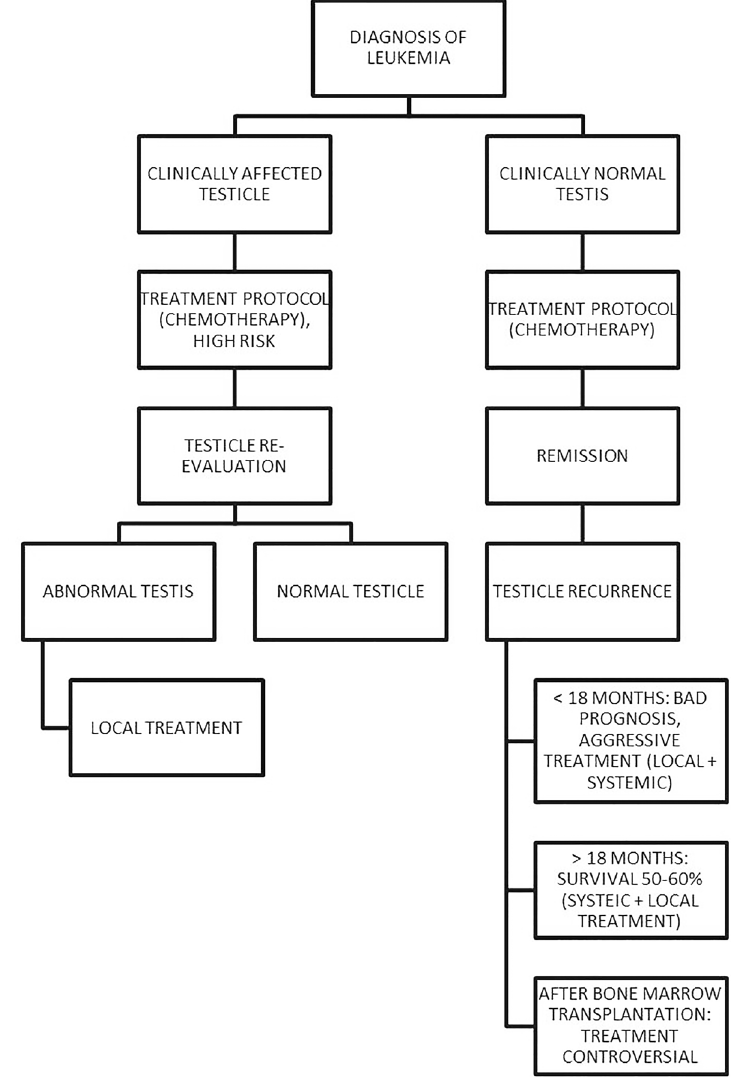
Figure 2 - Treatment algorithm suggested by the authors to treat ALL cases, according to the clinical situation and response to treatments, considering primary testicular affection and testicular recurrence. Local treatment in this context means either ipsilateral orchiectomy or radiotherapy with contralateral